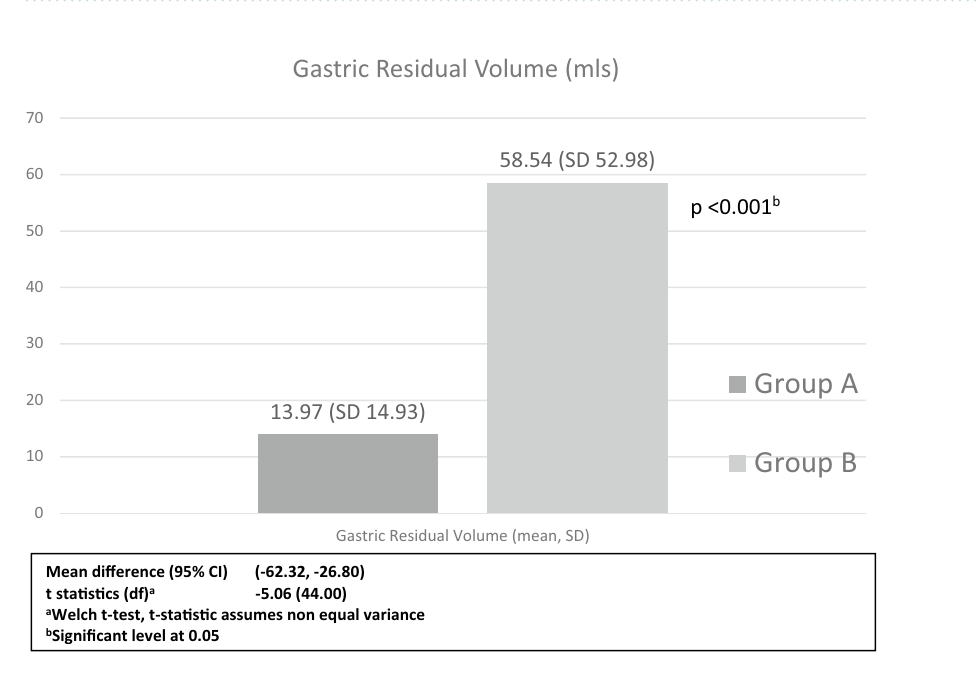
Table 1. Demography and gastroscopy findings. *Median (IQR). a Chi-square Test. b Independent t-test. c Mann-Whitney U test.